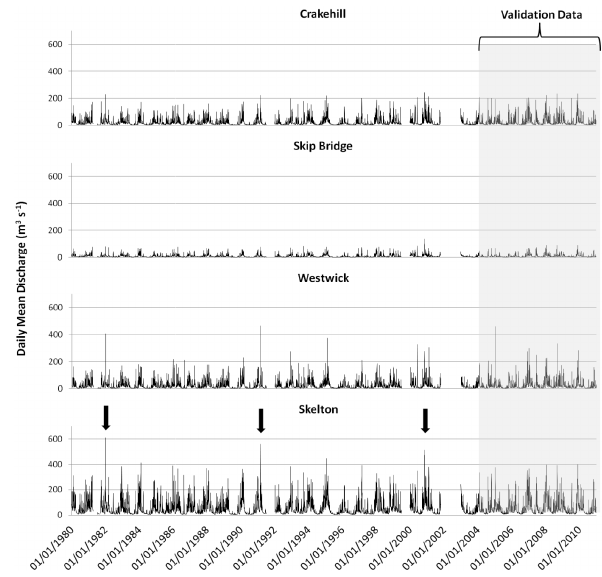
Figure 6. Hydrographs for the four gauging stations showing data partitioning.